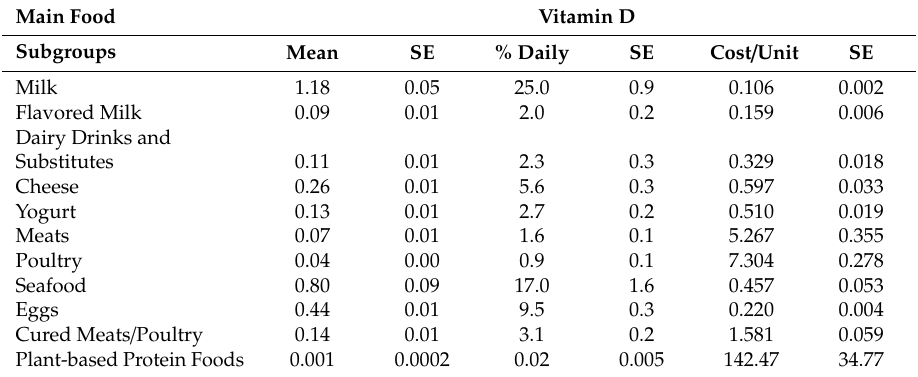
Table 12. Percent daily vitamin D (mcg) and cost ($) of vitamin D from eggs in adults, compared to USDA protein food